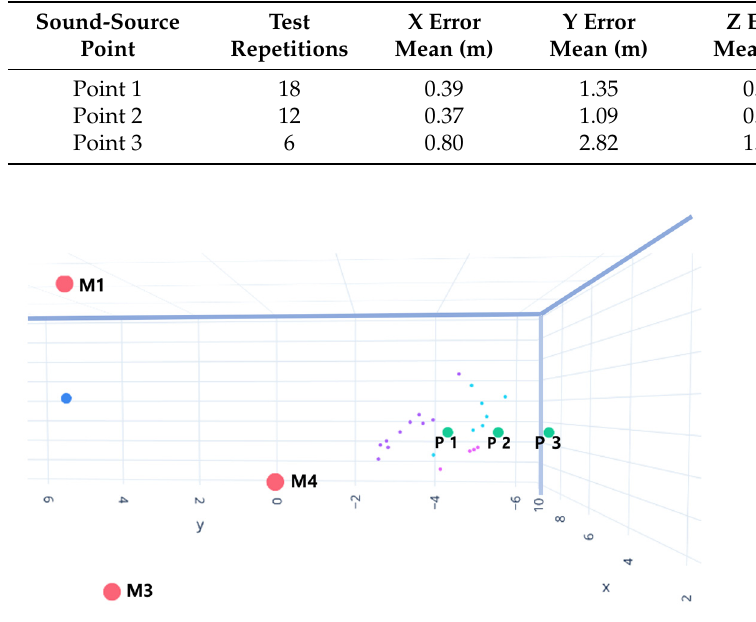
Figure 15. Results of validation test 2 in the section view.